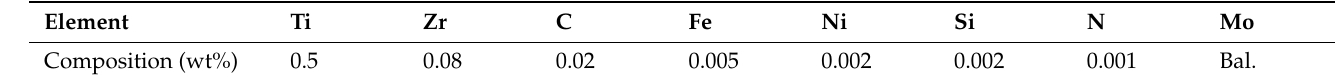
Table 3. Physical properties of Ni80A superalloy and TZM alloy.